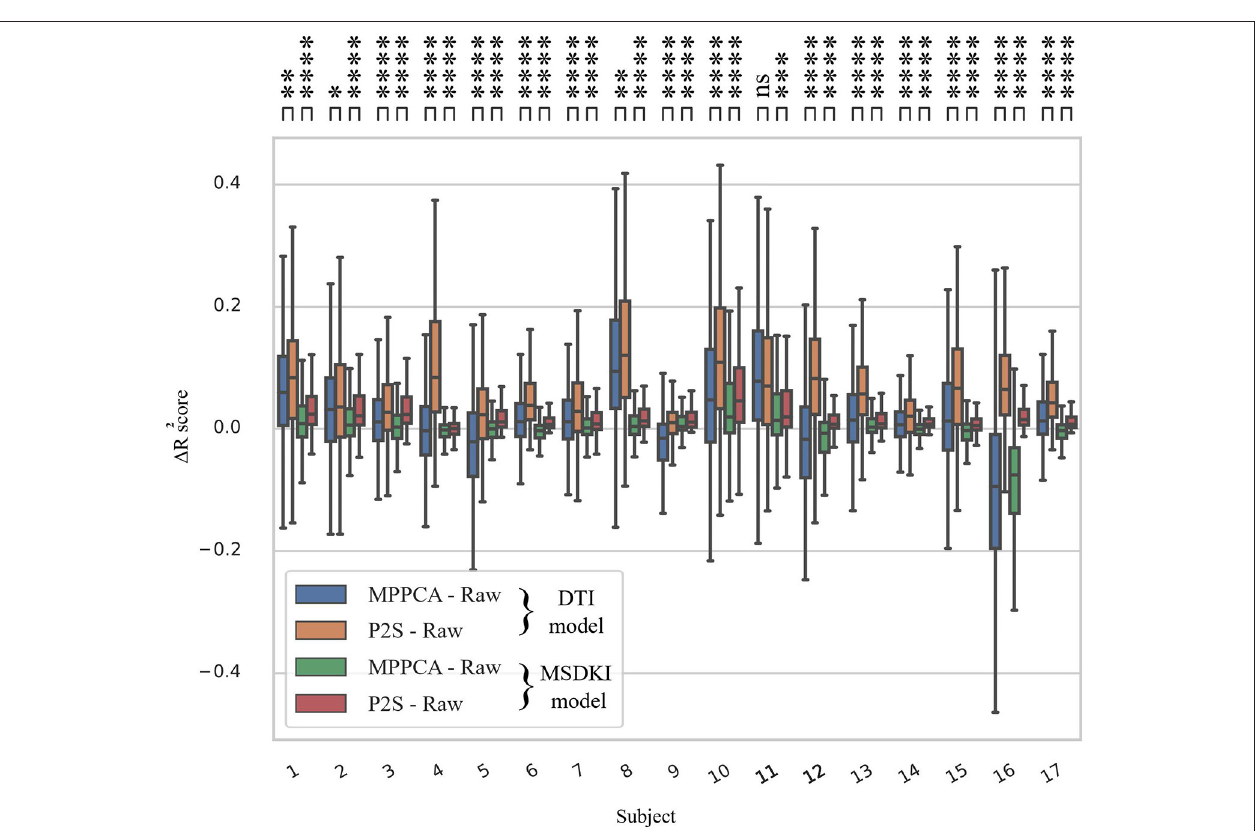
FIGURE 8 | Box plots quantifying the increase in R 2 metric after fitting downstream the diffusion tensor imaging and MSDKI models for the whole spinal cord volume across all subjects. The R 2 improvements in each case are plotted by subtracting the scores of model fitting on undenoised data (raw) from R 2 of fitting each denoised output. Note that the consistency of microstructure model fitting on Patch2Self (P2S) denoised data is higher than that obtained from Marchenko–Pastur, especially as regards MSDKI model. Ns, 5.00e − 02 < p ≤ 1.00e + 00; *, 1.00e − 02 < p ≤ 5.00e − 02; **, 1.00e − 03 < p ≤ 1.00e − 02; ***, 1.00e − 04 < p ≤ 1.00e − 03; ****, p ≤ 1.00e − 04 in two-sided t -test with Bonferroni